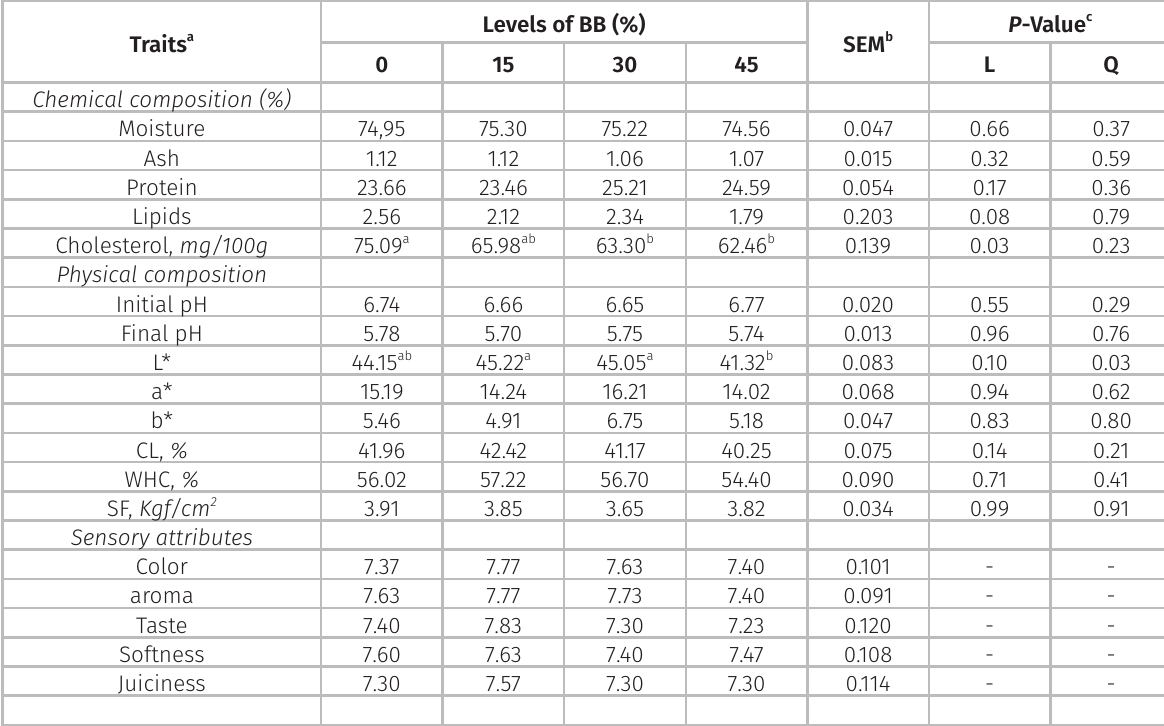
Table IV. Physicochemical characteristics and sensory attributes of the Longissimus thoracis et lumborum muscle of sheep fed with a diet containing biscuit bran